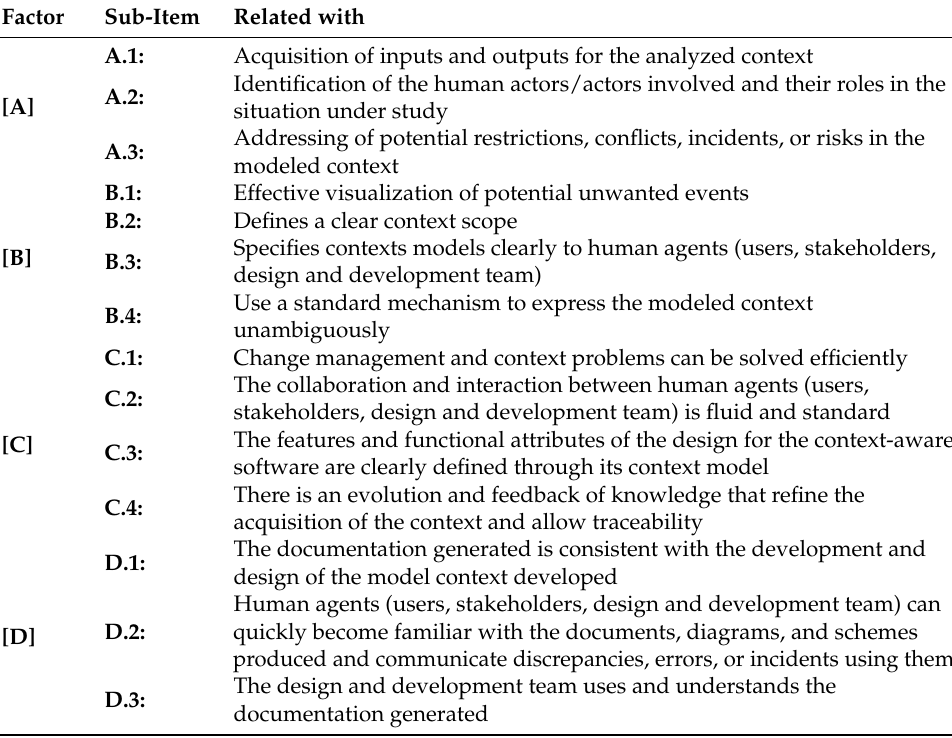
Table 4. Sub-Items evaluated for each